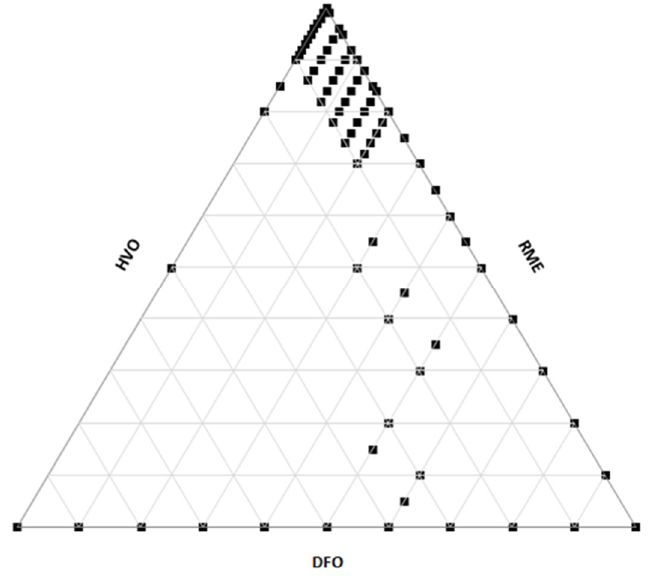
Figure 2. Ternary plot of analytical values % ( V/V ) for calibration data set.